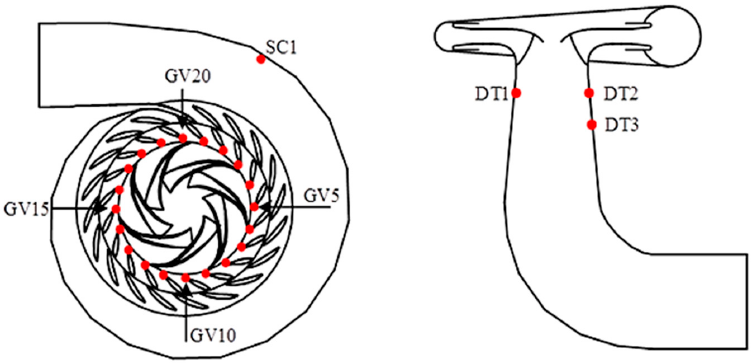
Figure 5. Pressure monitors in the whole passage.